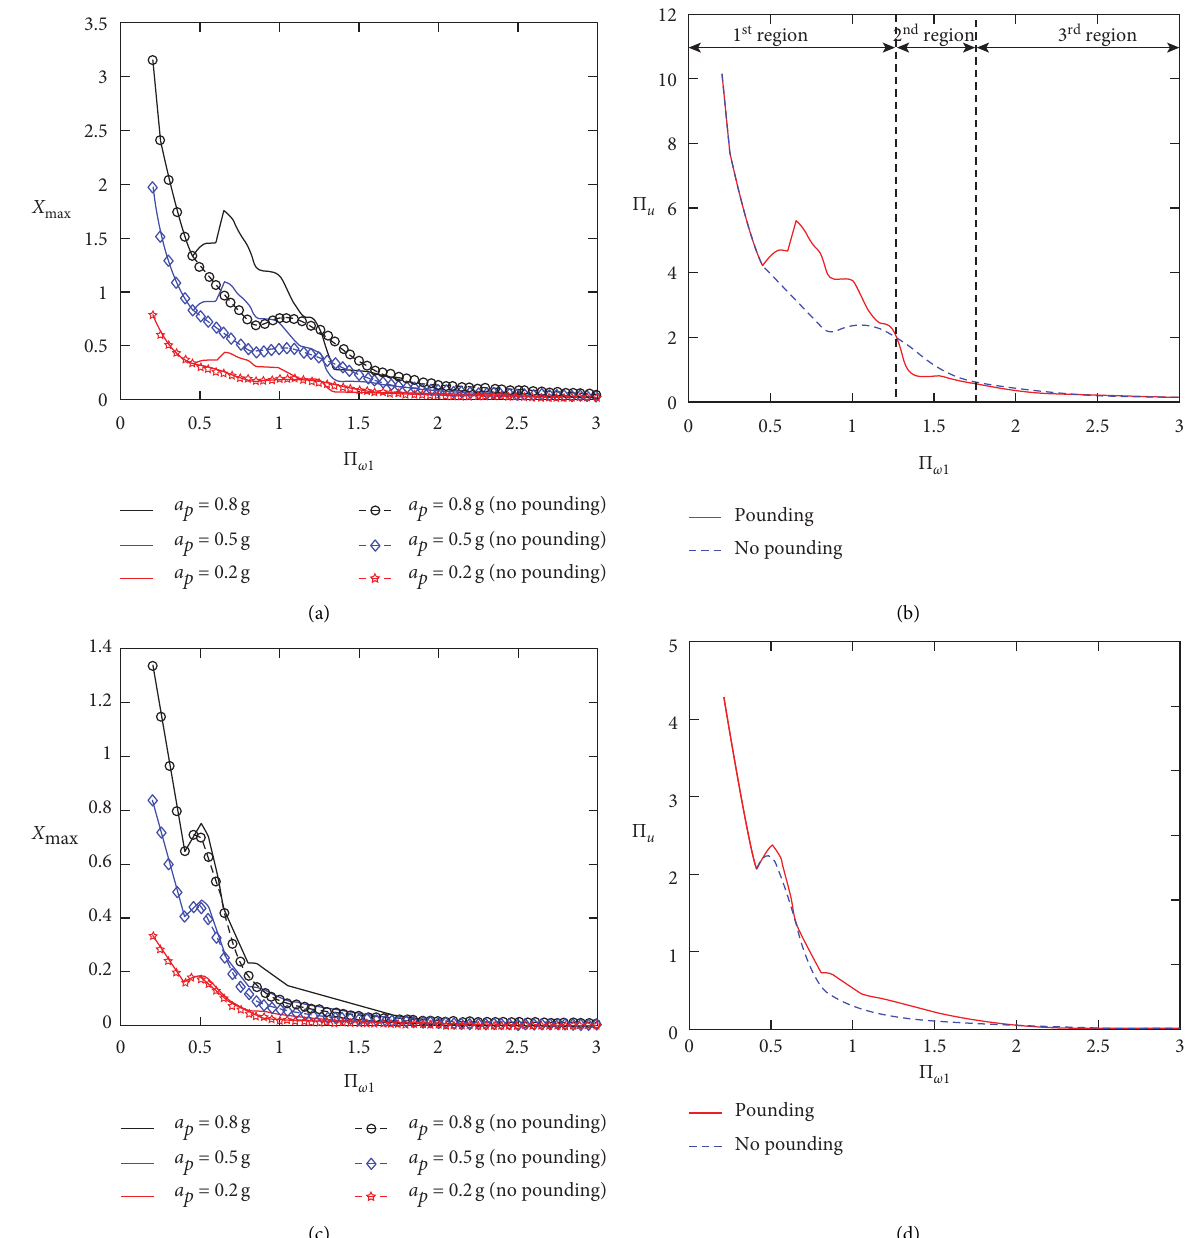
Figure 7: Dimensional and dimensionless peak displacement of the two inelastic SDOF structures under different amplitudes of ac- celeration. (a) Dimensional displacement of left-side structure. (b) Dimensionless displacement of left-side structure. (c) Dimensional displacement of right-side structure. (d) Dimensionless displacement of right-side